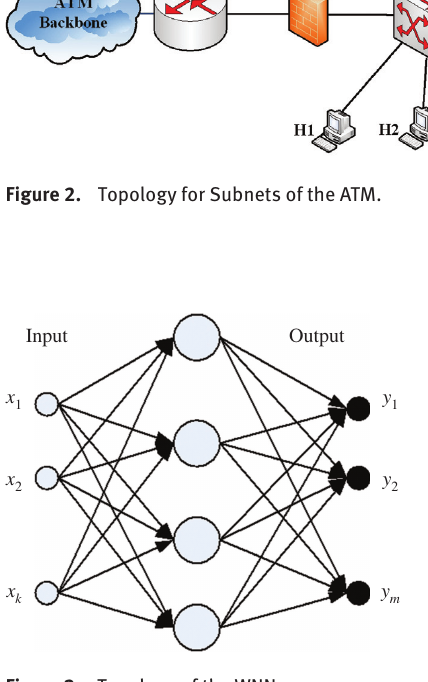
Figure 3. Topology of the